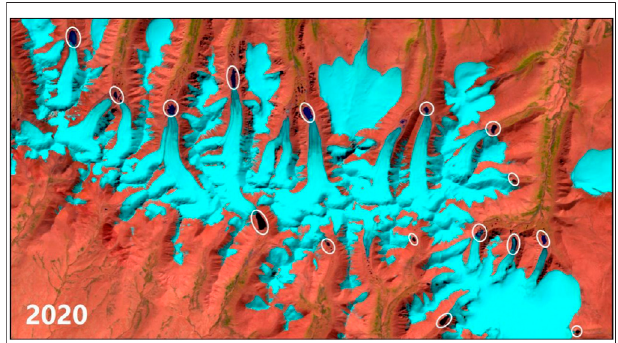
FIGURE 8 | Distribution of glacial lakes in the Turgen Daban Range in 2020.